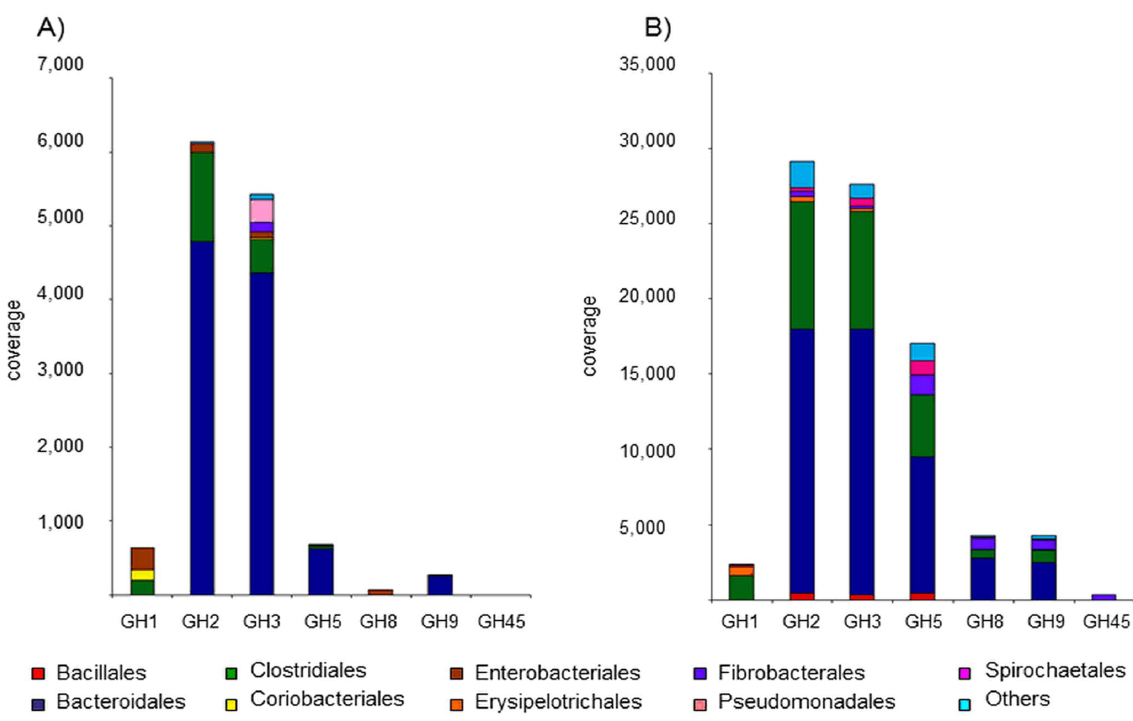
Figure 4. Overall coverage of selected cellulolytic GH family genes in the feces samples in relation to their phylogenetic affiliation. A ) three-weeks-old elephant, B ) six-years-old elephant.